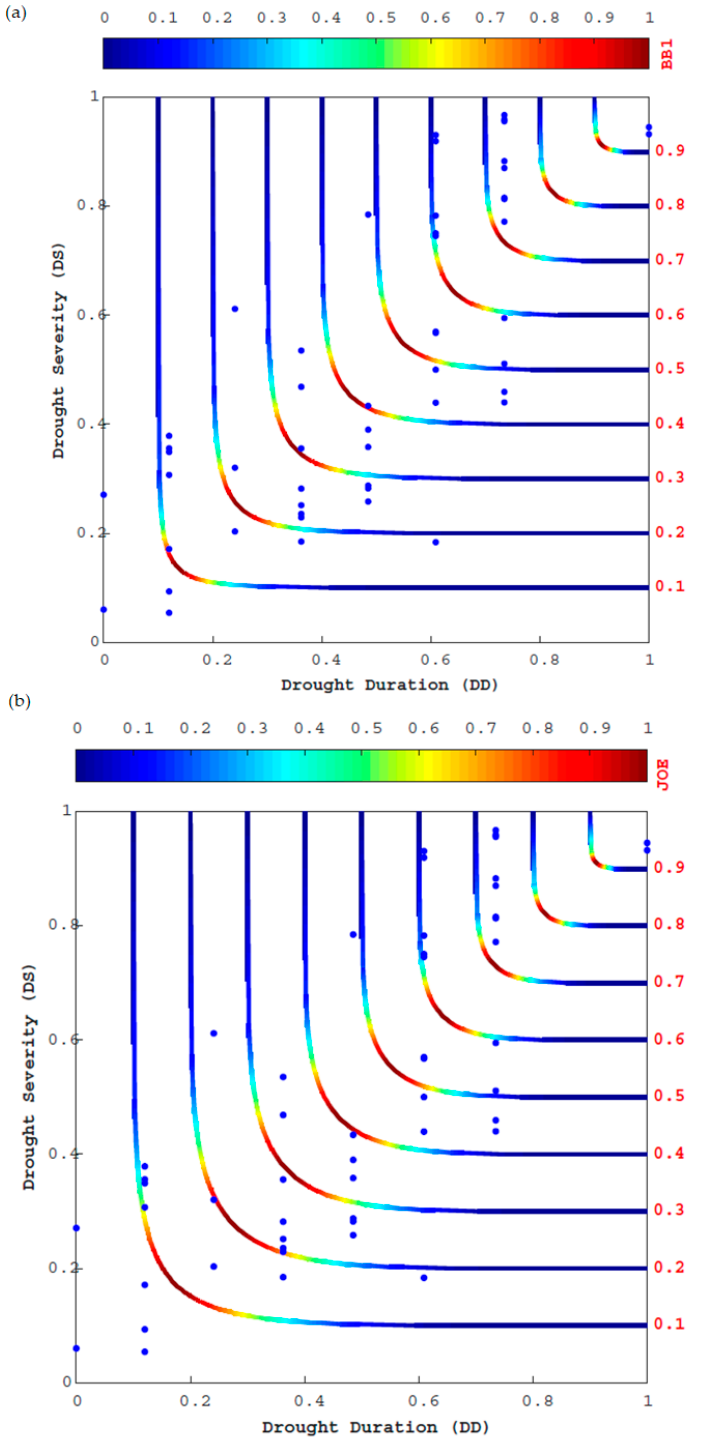
Figure 6. A dependence structure of drought duration and severity based on SPI-12 time series. In the figure, ( a ) corresponds to BB1 and ( b ) corresponds to Joe copulas.